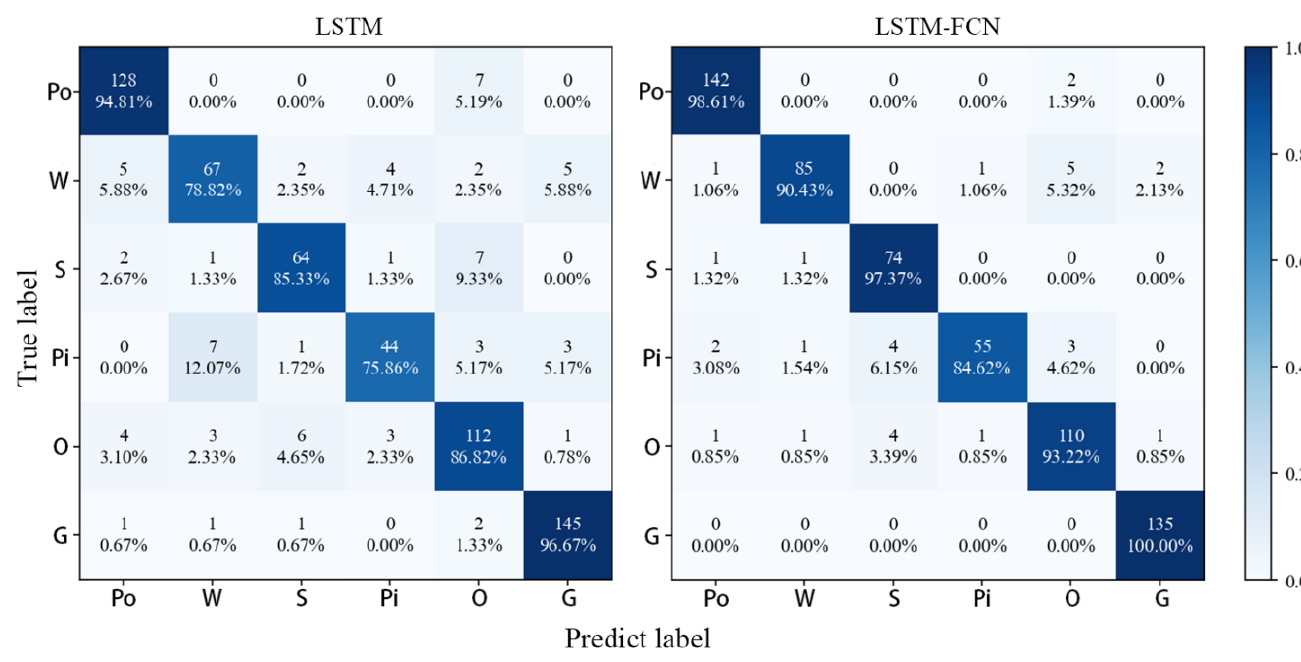
Figure 11. LSTM, LSTM-FCN confusion matrix. Table 9. Branching